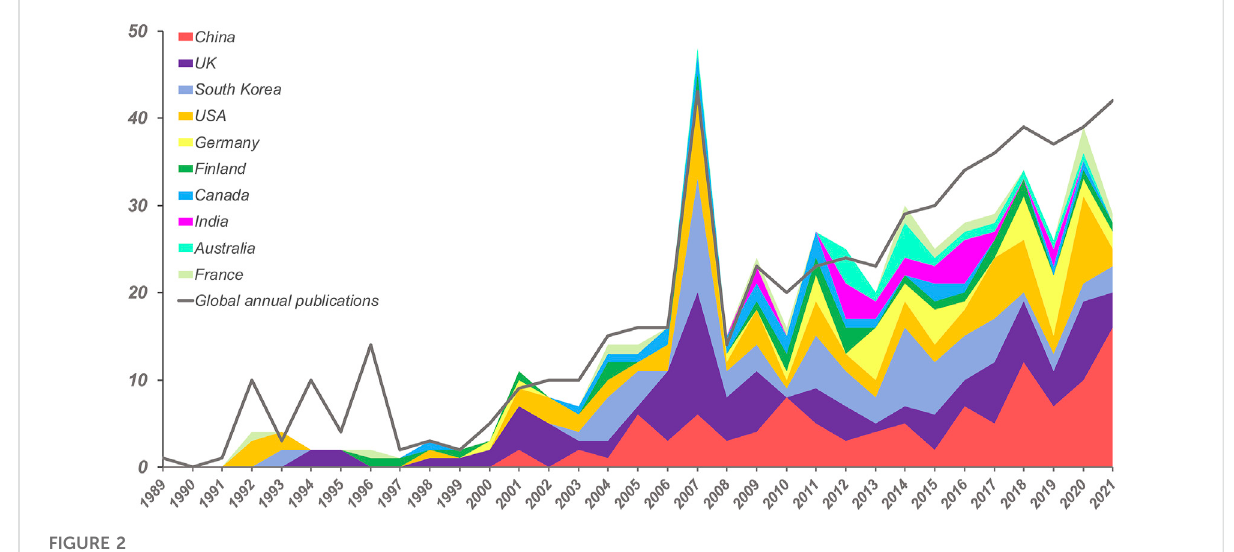
FIGURE 2 Annual growth trends of publications by global and top 10 countries on electrical impedance tomography hardware research from 1989.01.01to2021.12.31.Thegreylineindicatesthetrendofannualworldpublications,thecolorsindicatethetop10mostproductivecountries.The width of the color plate indicates the number of